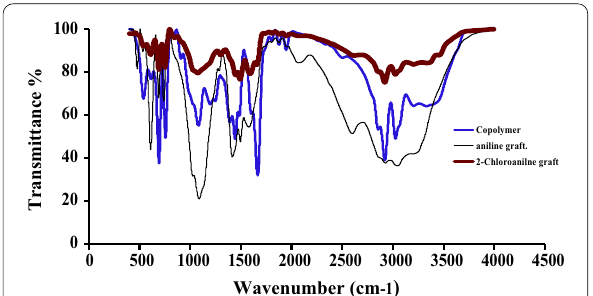
Fig. 1 IR spectrum of the investigated polymeric samples